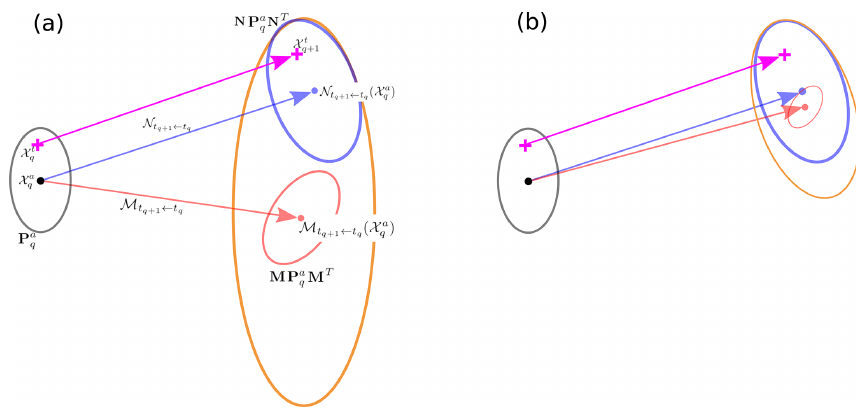
Figure 1. Illustration of the evolution of the uncertainty by the nature and the numerical model: the generic situation (a) and the particular situation where the forecast lies within the nature uncertainty and where the model is diffusive (b) . The predictability-error covariance of the nature NP a q N T (of the model MP a q M T ) is indicated by the blue (red) ellipse. The forecast-error covariance matrix is indicated by the orange